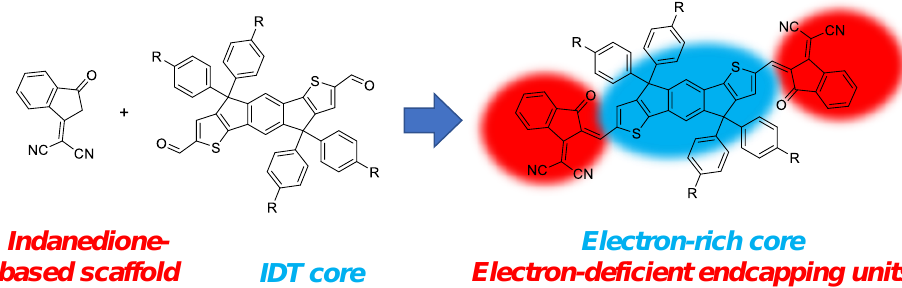
Figure 1. Structure of the prototypical IDIC NFA.